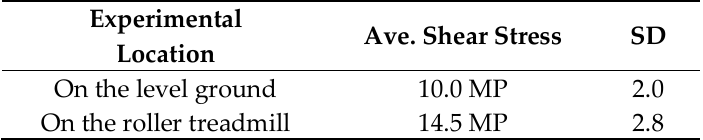
Table 1. The maximum shear stress calculated by the torque in hard